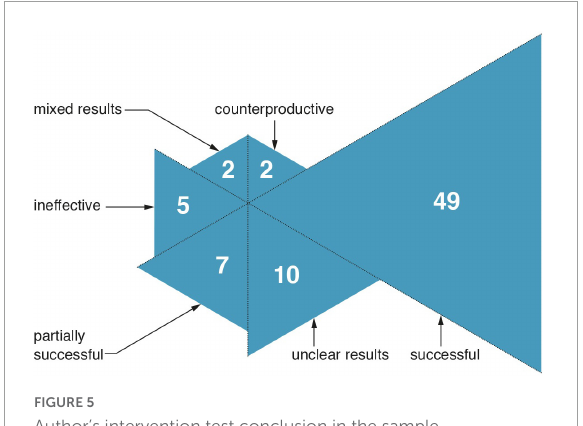
FIGURE5 Author’s intervention test conclusion in the sample.